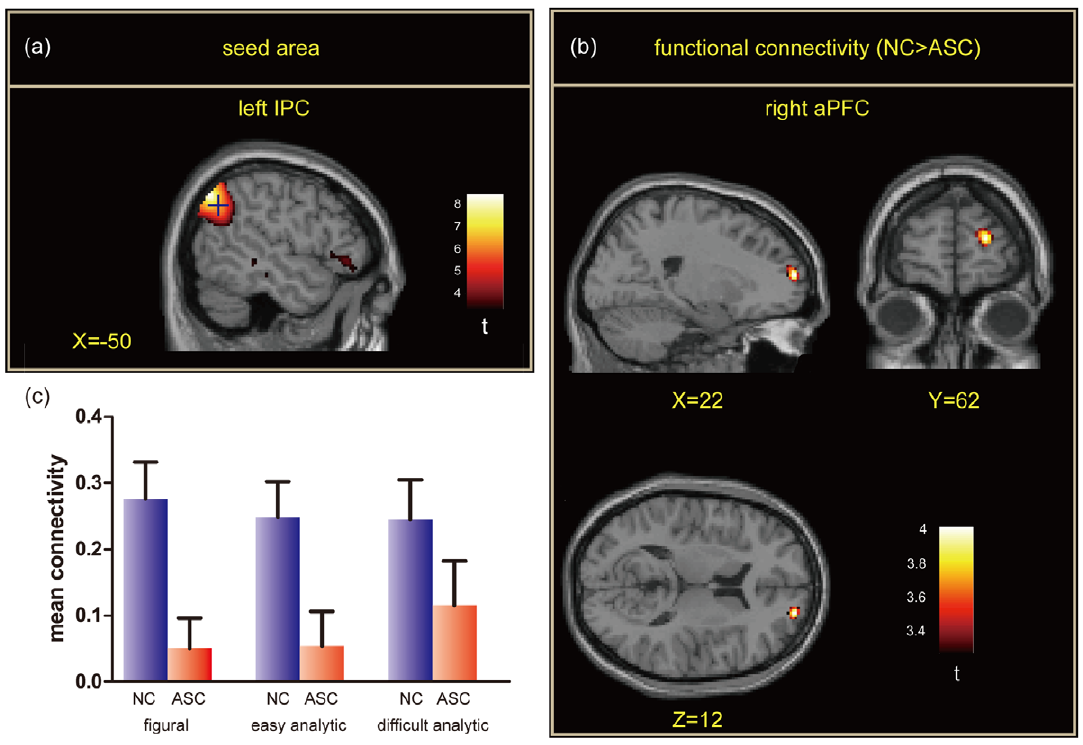
Figure 5. Group comparison of functional connectivity throughout all conditions. (a) The location of the seed area in the left inferior parietal cortex (IPC). The cross hair shows the focus of the seed area. (b) The right anterior prefrontal cortex (aPFC) showing reduced connectivity with the left IPC in autism spectrum condition (ASC) compared with normal control (NC). The peak of the group difference is shown in the MNI space. The cluster size was 109 voxels. p , 0.001, uncorrected for multiple comparison at the voxel level. (c) Mean connectivity (Z value) in the right aPFC.